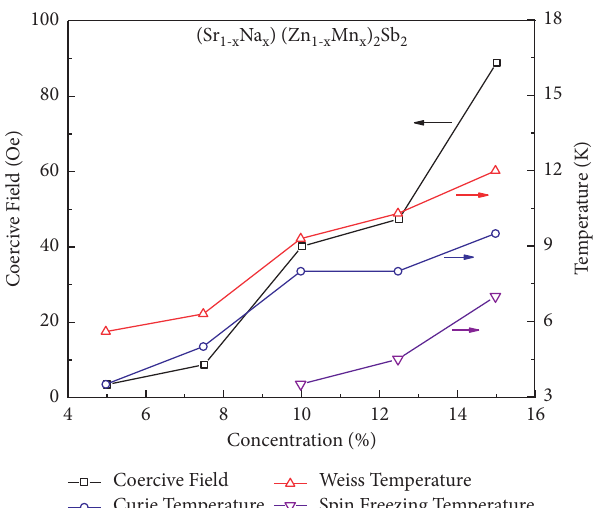
Figure 4: The Curie temperature, Weiss temperature, spin freezing temperature, and coercive field versus doping level x of ( Sr Na x )( Zn Mn x ) Sb . 1 − x 1 − x 2 2 Table 2: Curie temperature T C , Weiss temperature θ , effective magnetic moment